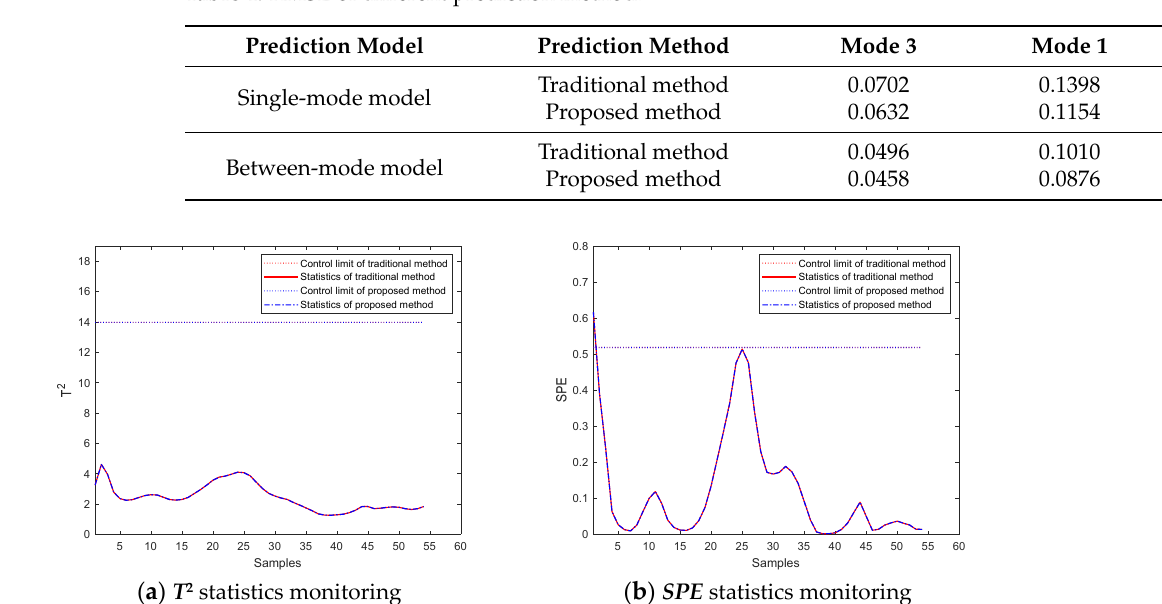
Figure 12. Multi-mode online prediction of mode 3. Table 4. RMSE of different prediction method.